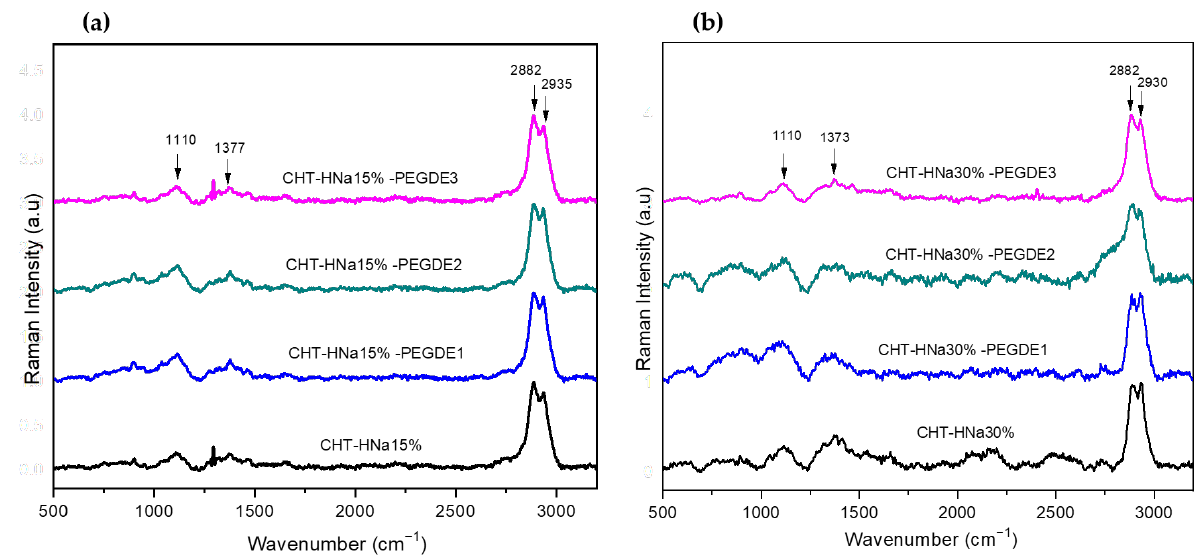
Figure 2. ( a ) Raman spectra of PEGDE crosslinked CHT films. HNa 15% ( a ) and HNa 30% ( b ).